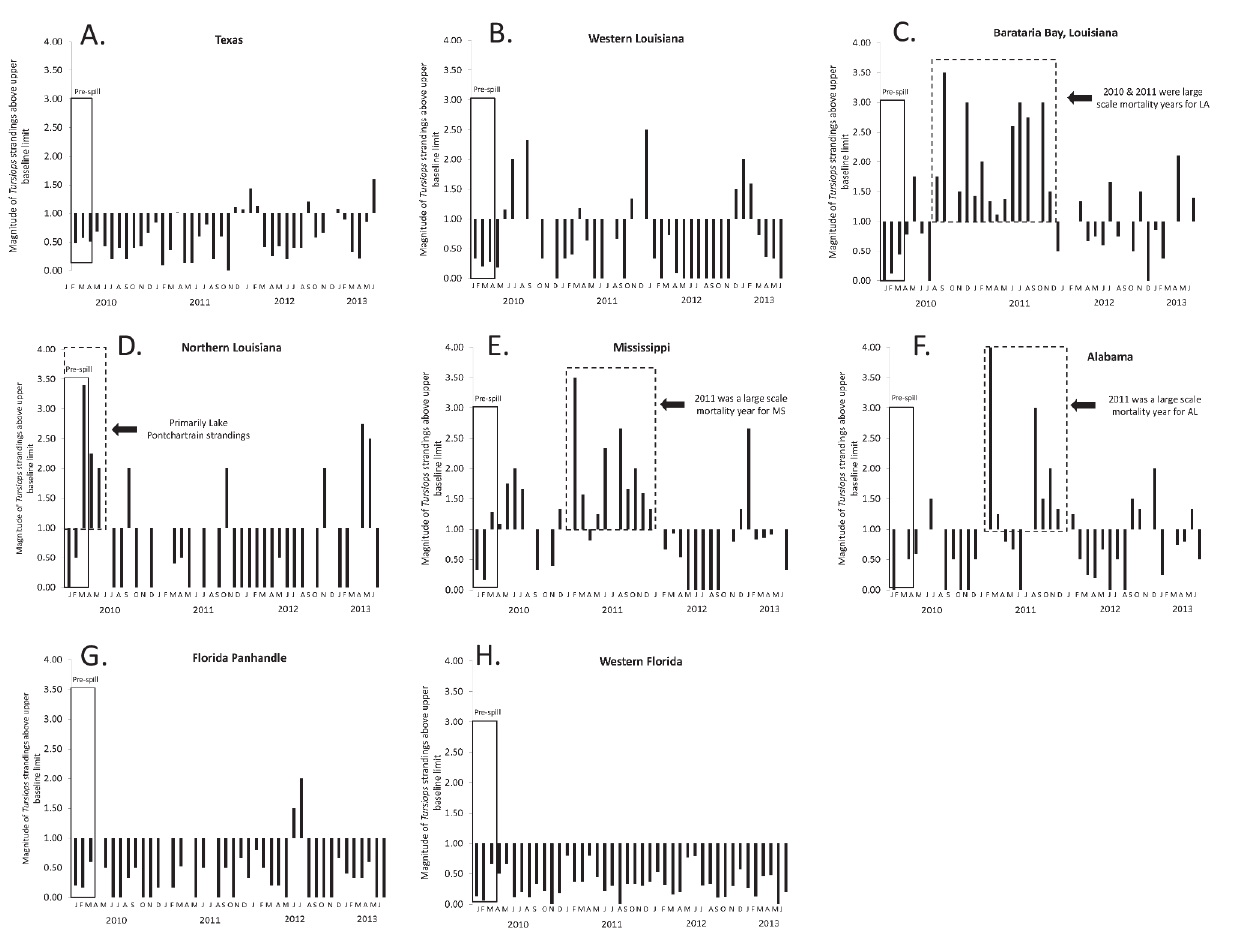
Fig 4. Magnitude of numbers of stranded common bottlenose dolphins ( Tursiops truncatus ) above the upper baseline limit (1990 – 2009) in the northern Gulf of Mexico during the ongoing unusual mortality event (January 2010-June 2013). From west to east; A) Texas, B) Western Louisiana C) Barataria Bay, Louisiana, D) Northern Louisiana, E) Mississippi, and F) Alabama, G) Florida Panhandle, and H) Western Florida. The solid box marked ‘ Pre- spill ’ represents time before the Deepwater Horizon oil spill in the northern Gulf of